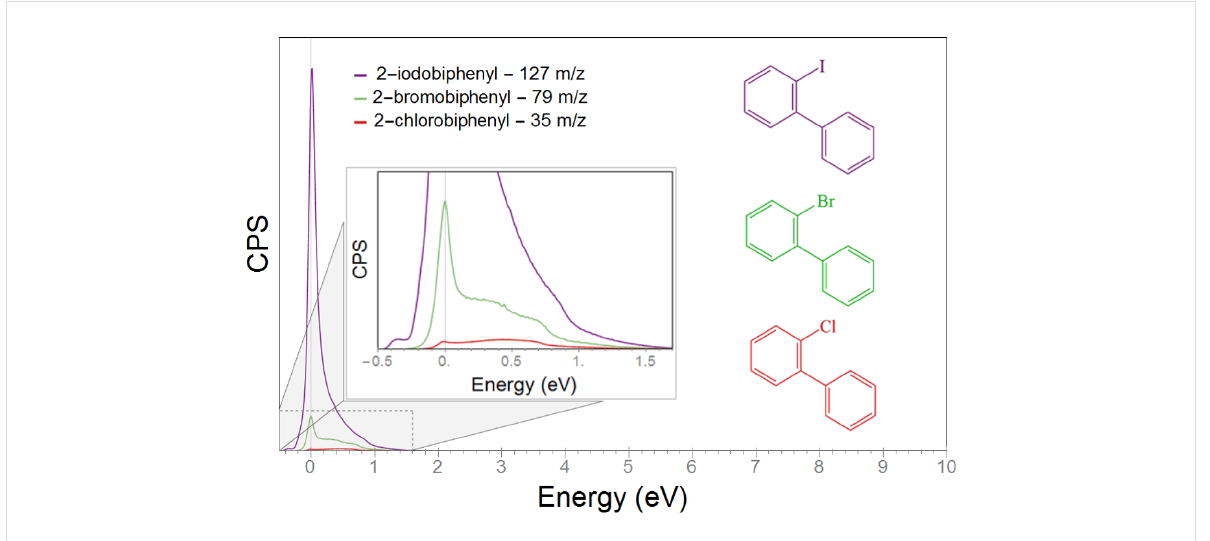
Figure 1: Negative halogen ion yield curves for dissociative electron attachment to 2 ′ -chloro-1,1 ′ -biphenyl (red), 2 ′ -bromo-1,1 ′ -biphenyl (green) and 2 ′ -iodo-1,1 ′ -biphenyl (violet) in the incident electron energy range from 0 to 10 eV. The region from 0 to about 1.5 eV is expanded to allow better com- parison of the 2 ′ -chloro-1,1 ′ -biphenyl and 2 ′ -bromo-1,1 ′ -biphenyl ion yield. The respective molecular structures are shown at the top of the